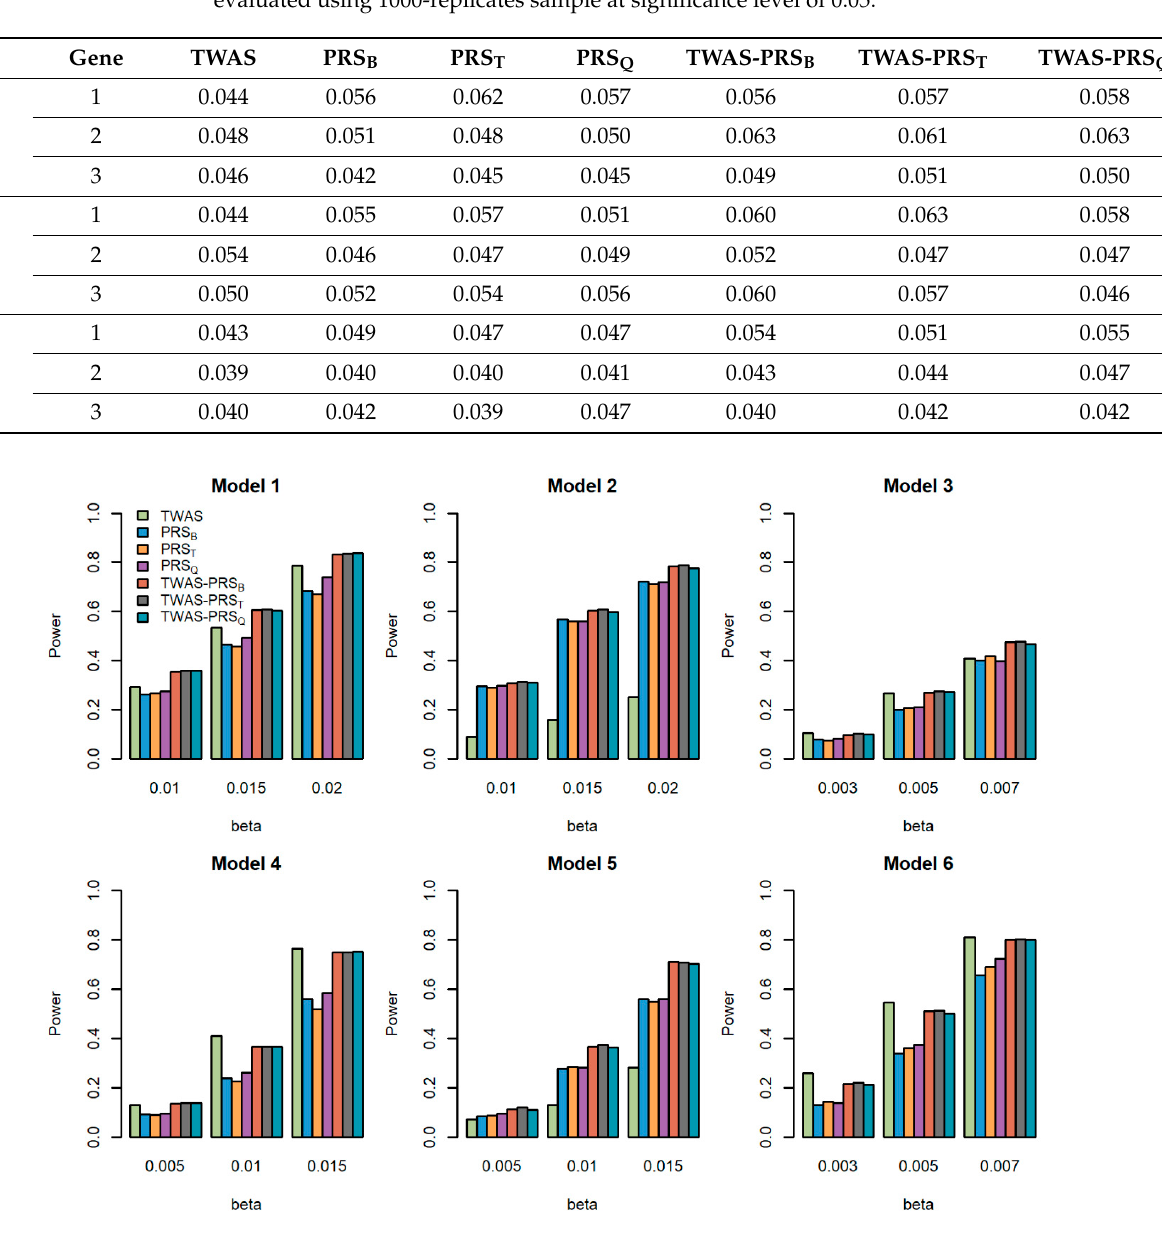
Table 1. Estimated type I error rates of the seven methods for different sample sizes of GWAS data sets (5000, 10,000, and 20,000) and different genes (gene1, geme2, and gene3). Type I error rates are evaluated using 1000-replicates sample at significance level of 0.05.